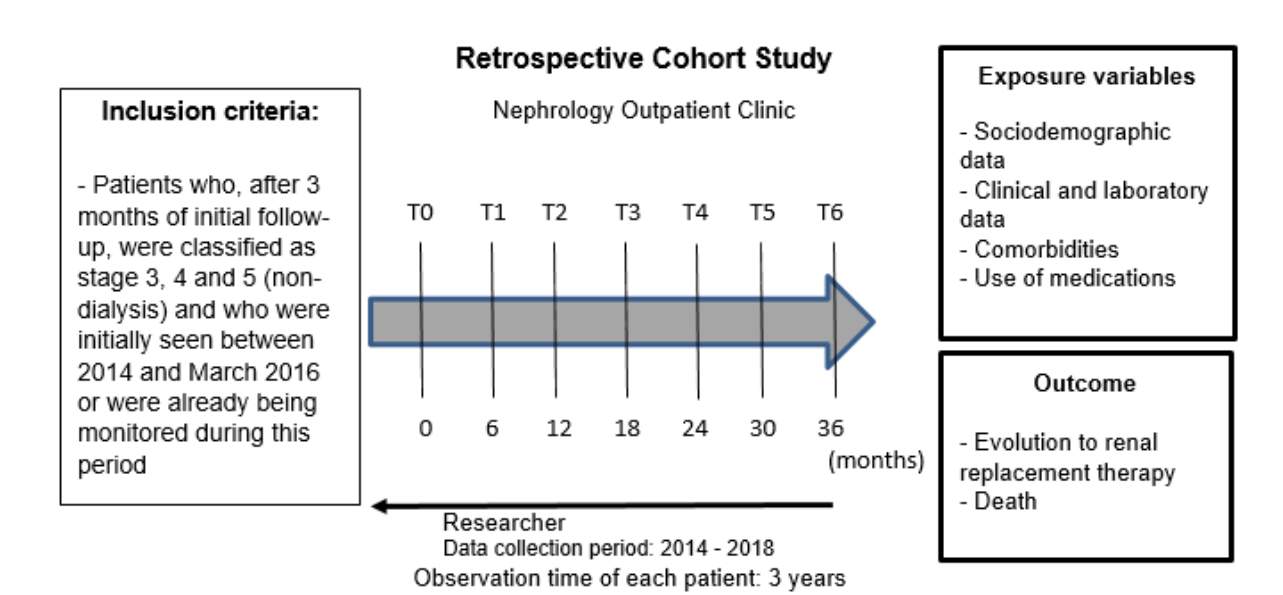
FIGURE 1 - Schematic representation of the stages of construction of the cohort study in patients with CKD in stages 3 to 5-ND in Divinópolis (MG),